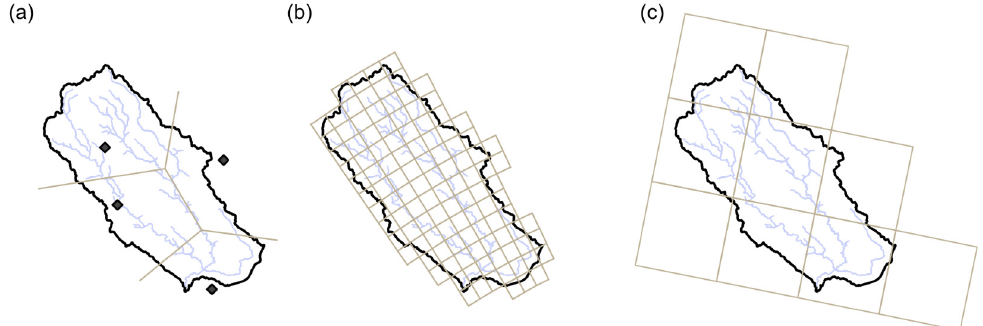
Figure 2. Spatial granularity (before aggregation) of the data precipitation products from ( a ) rain gauges’ Thiessen polygons, ( b ) ground-based weather radar’s derived N1P product grid cells, and ( c ) NWM product grid cells.